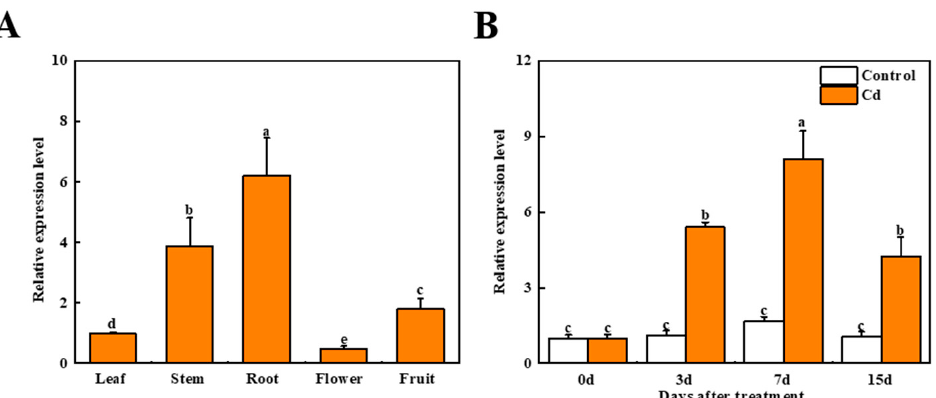
Figure 1. The relative expression level of Sl1 in tomato plants. ( A ) The relative expression level of Sl1 in different tissues of tomato. ( B ) Time course of the relative expression level of Sl1 in tomato root with and without Cd stress. The data presented here are the average of three biological replicates ( ± SD). Different letters indicate a significant difference ( p < 0.05, Tukey’s test).